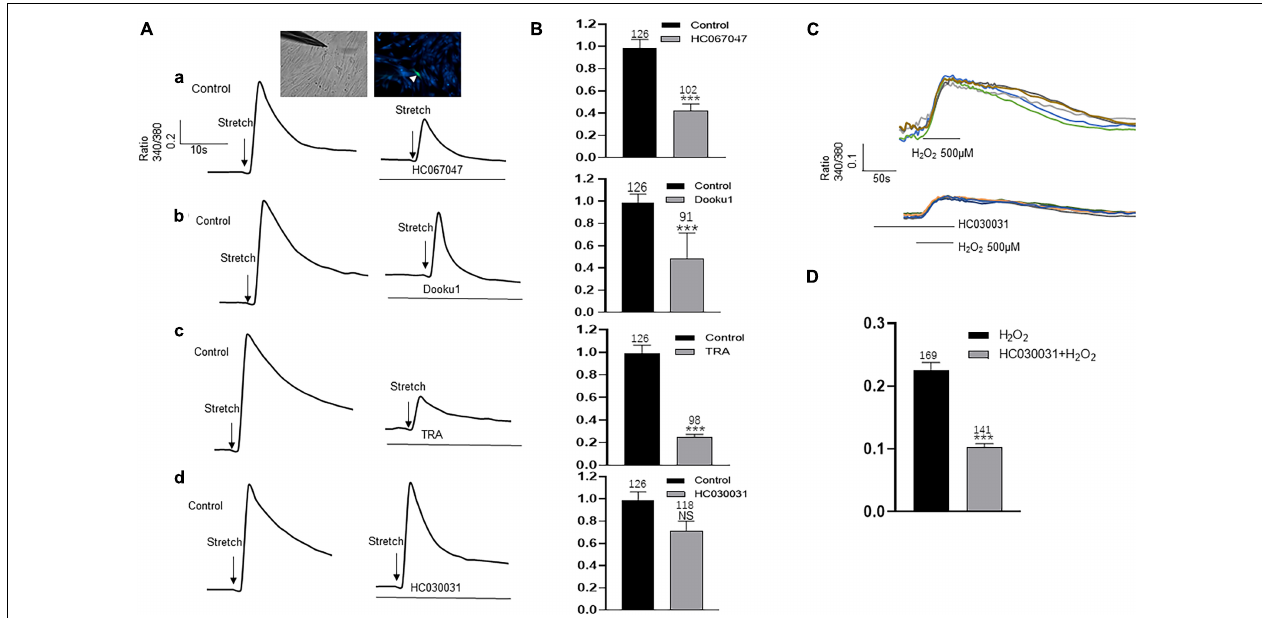
FIGURE 6 | Antagonists of TRP (V2 and V4 but not A1) and Piezo1 channels inhibit stretch induced increase in [Ca 2 + ] i in cultured LP-ICs. (A) , Typical traces demonstrating that pretreatment with the antagonist of TRPV4 ( a , HC067047, 1 µ M), Piezo1( b , Dooku1, 10 µ M), and TRPV2 ( c , TRA, 10 µ M) but not TRPA1 ( d , HC030031, 30 µ M) blocked stretch induced increase in [Ca 2 + ] i . Inset indicates a cell was subjected to a step of 1 µ m movement of a stimulation glass micropipette, and a fluorescence signal change was detected (indicated by a arrowhead). (B) , Summary data for the blocking effects of the antagonists. (C) , Typical traces showing that H 2 O 2 (500 µ M) induced an increase in [Ca 2 + ] i , which was blocked by pretreatment with TRPA1 antagonist. (D) , Summary data for the blocking effects of TRPA1 antagonist. n above each bar indicates the cell number examined. *** p <